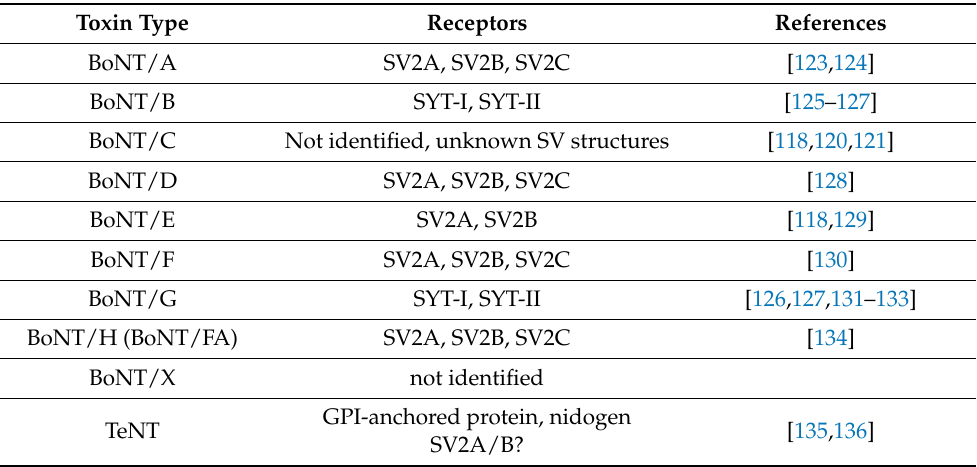
Table 1. Protein receptors for clostridial